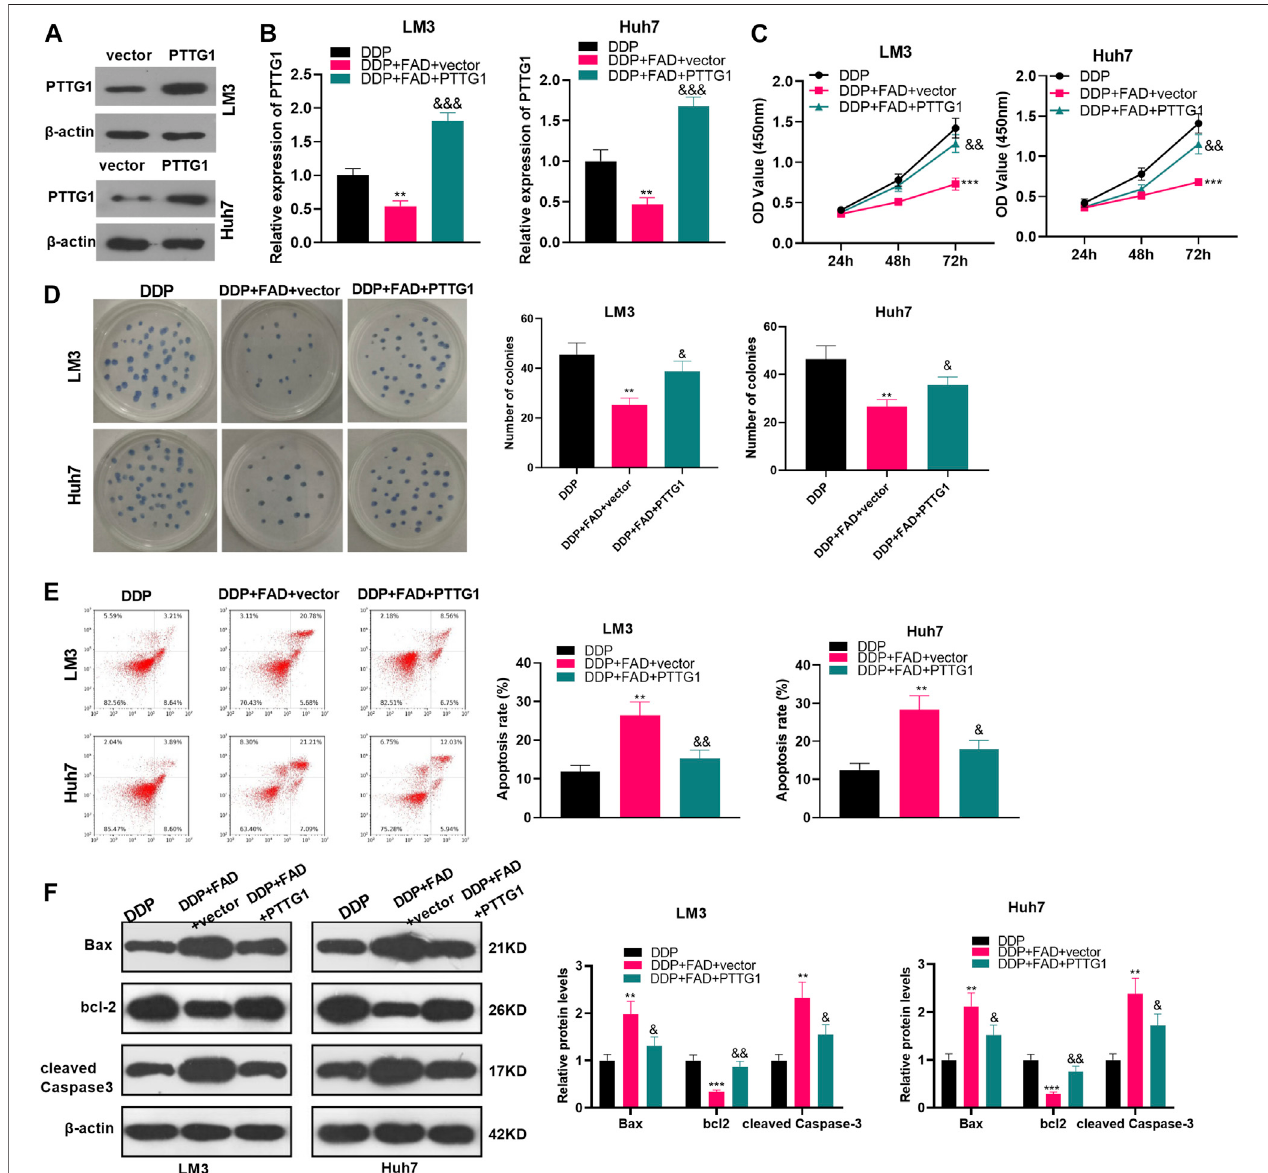
FIGURE 6 | Overexpressing PTTG1 weakened the promotion of FAD-enhanced chemosensitivity of HCC cells to DDP. (A) . HCC cell lines (Huh7 and LM3) were transfected with PTTG1 overexpressing plasmids or negative vector. The protein level of PTTG1 was detected by WB. (B) . HCC cell lines (Huh7 and LM3) were treated withDDP (2 μ g/mL) and FAD (10 µM)for24 h. (B) .qRT-PCRwasimplemented toverify the STAT3/PTTG1expression. (C, D) .CCK-8 assay andcolonyformationwere conductedtodetectcellproliferation. (E) .FCMwasappliedtotestapoptosis. (F) .ExpressionofBax,bcl2,andcleavedCaspase3wasdetectedbyWB.** p < 0.01, *** p < 0.001 (vs. DDP group). & p < 0.05, && p < 0.01, &&& p < 0.001 (vs. the DDP + FAD + vector group). N (cid:2)